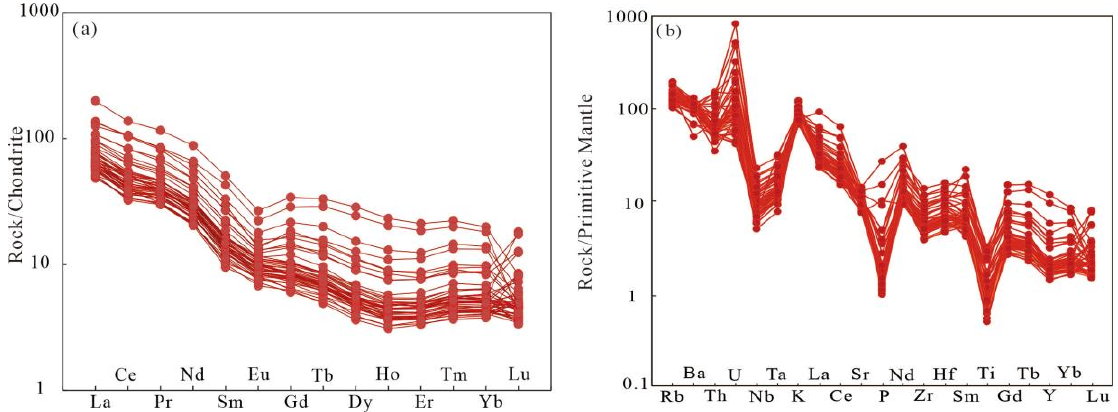
Figure 6. Chondrite normalized REE pattens ( a ) and primitive mantle normalized trace element spider diagrams ( b ) for the Sandstones in northern Songliao Basin (after Sun, S.S. and McDonough. [39]).